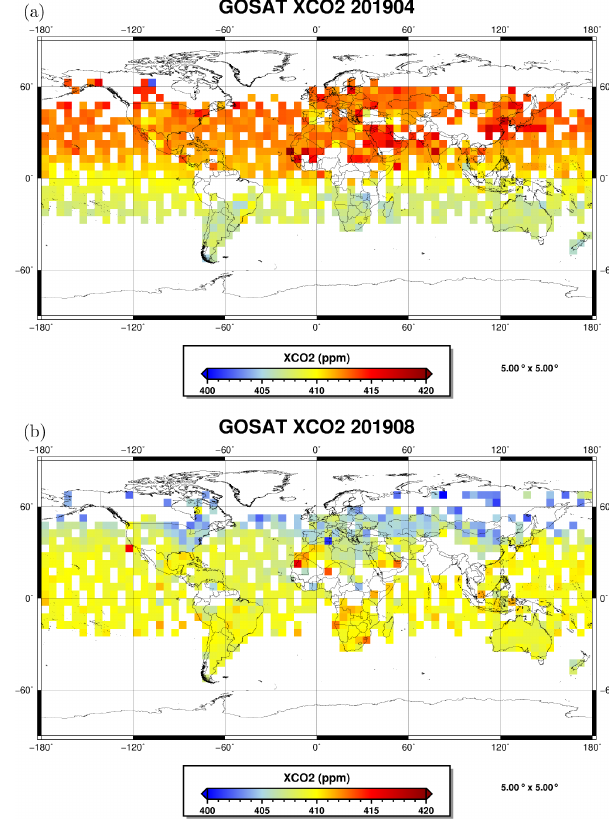
Figure 11. Example for gridded GOSAT XCO 2 data. (a) April 2019. (b) August